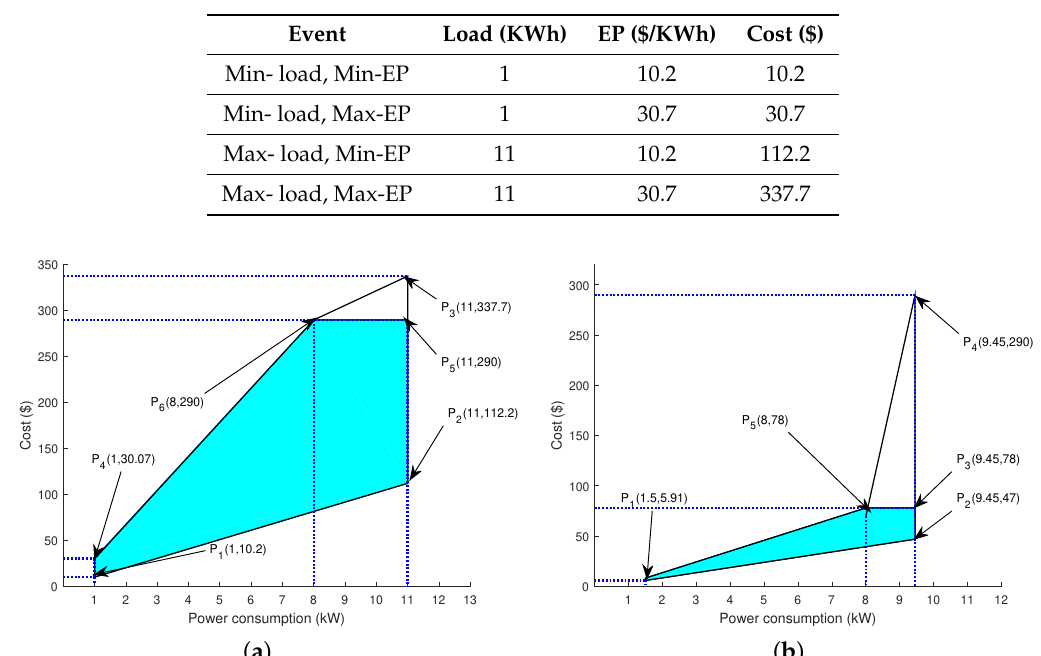
Table 5. Cost results against various load and price profiles considering RTP.